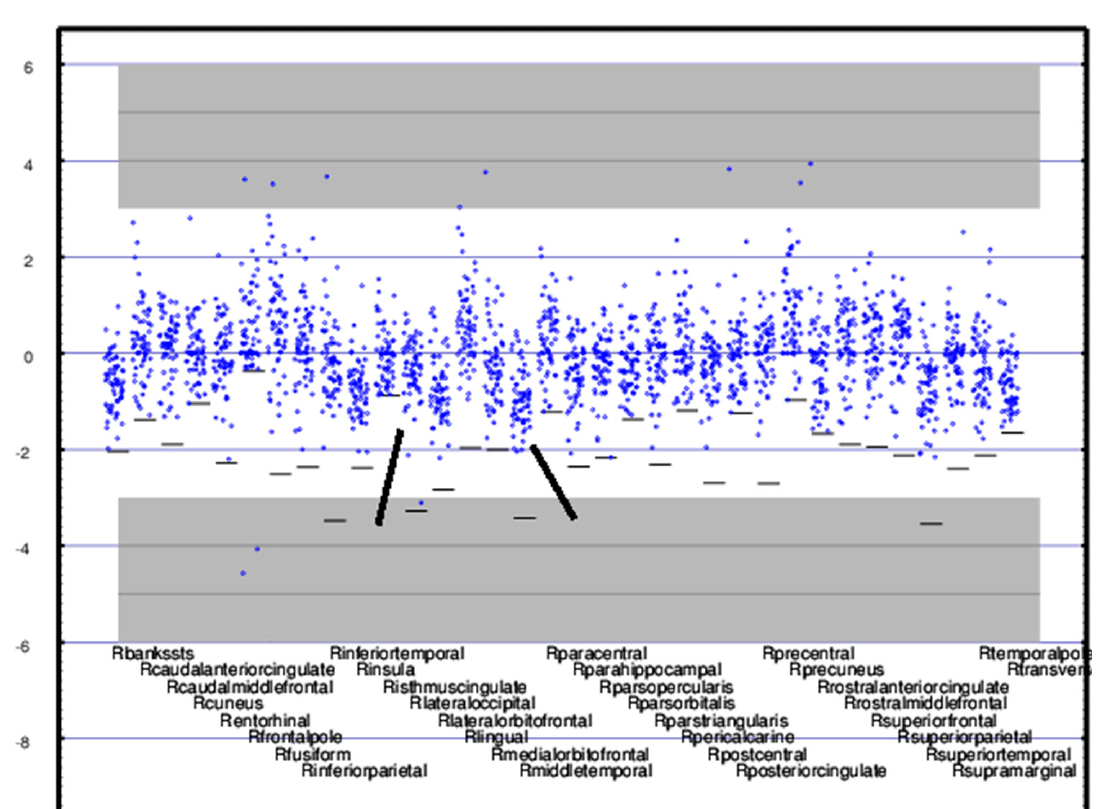
Figure 5. Regional activity ( z-score ) is shown for each TEAM-TBI subject for 34 right cortical regions. As in Figure 2, each horizontal bar represents the floor below which no measure can go. The right middle temporal and lateral occipital cortices, indicated with the wide black bars, contributed significantly to the classifier. Note that the means for some regions are greater than zero, some less. See the Figure 4 legend for details.